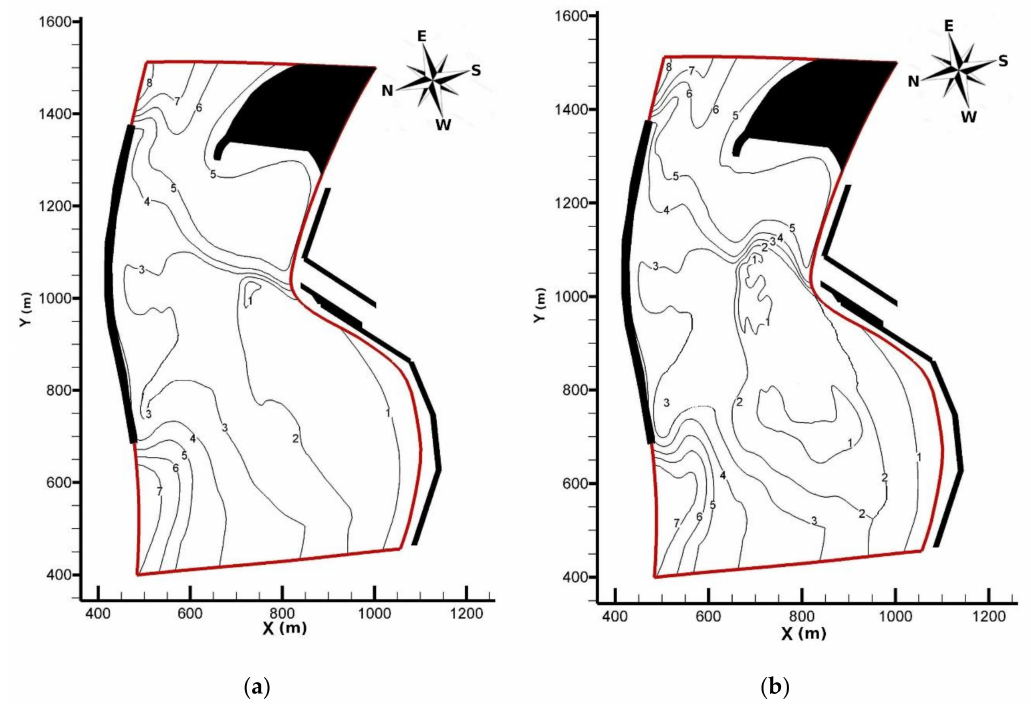
Figure 8. Configuration 1. Still water depth, measured from mean water level, after: ( a ) one year; and ( b ) three years.